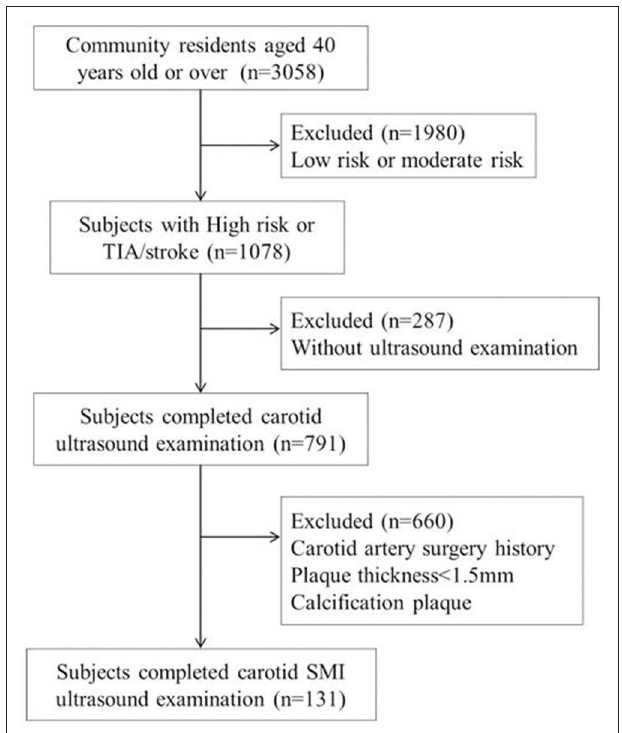
FIGURE 1 | Flow chart of the study sample and a description of the missing